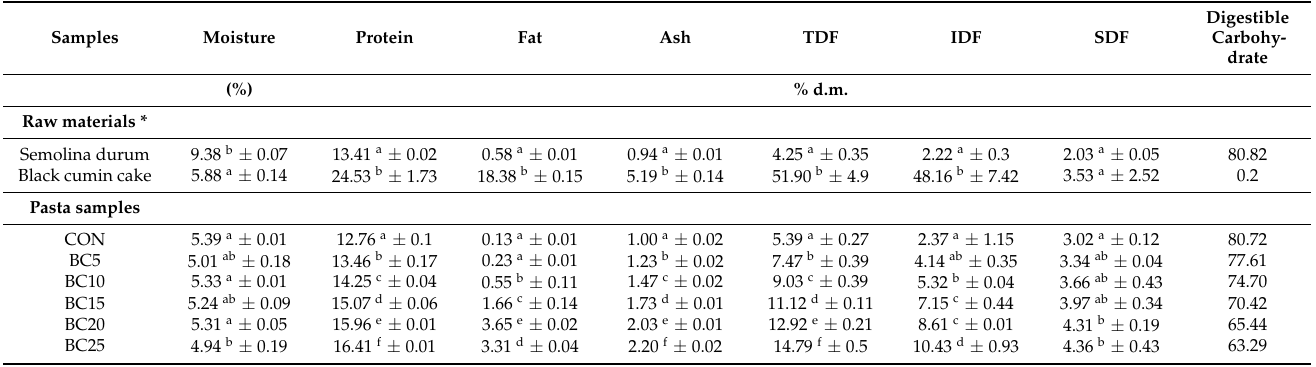
Table 2. Basic chemical composition of raw material and pasta